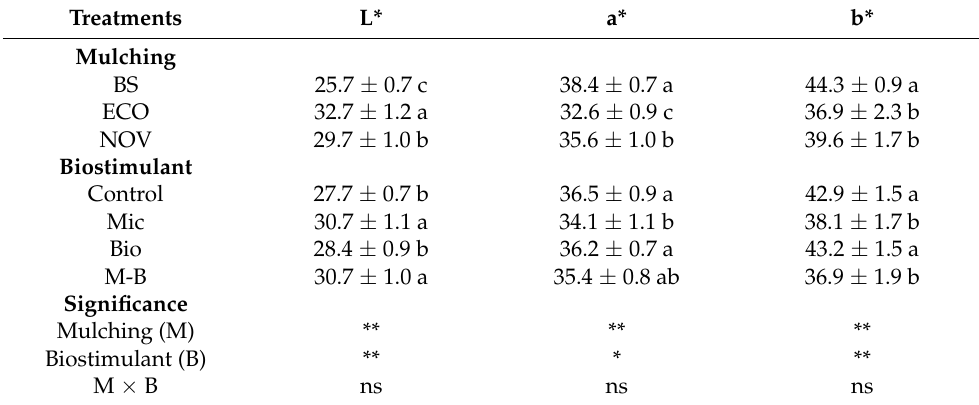
Table 3. Color parameters (L*: brightness; a*: green intensity, chroma component ranging from green (–60) to red (+60); b*: chroma component ranging from blue (–60) to yellow (+60)) as affected by mulching (ECO: biodegradable film Ecovio; NOV: biodegradable film MaterBi ® ; BS: bare soil) and biostimulant application (Bio: treated with Phylgreen ® ; Mic: treated with Trianum-P ® ; M-B: combination of Bio and Mic; Control: not treated).